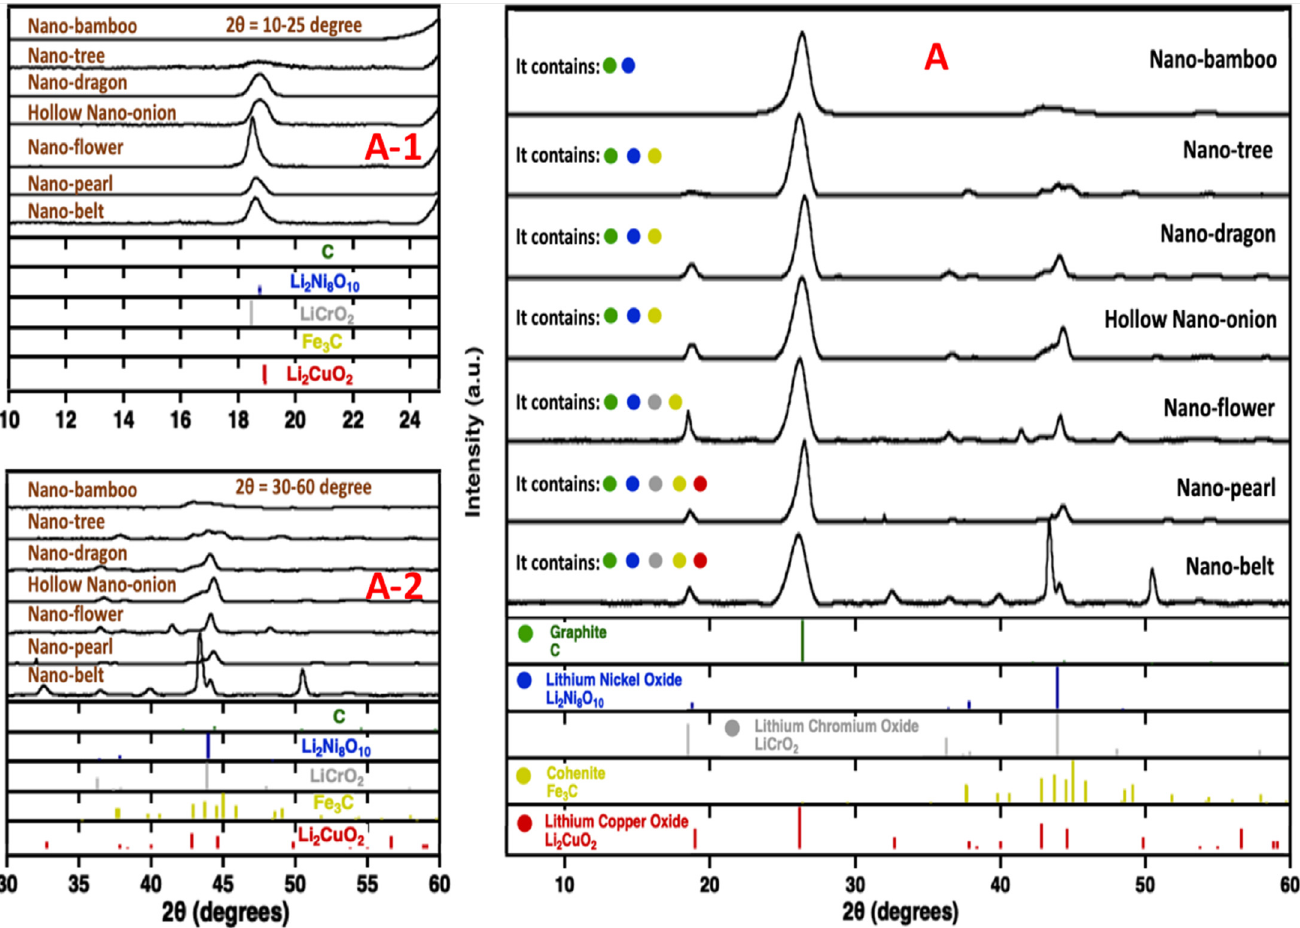
Figure 16. XRD of the synthesis product consisting of various labeled unusual nanocarbon morphologies synthesized by the electrolytic splitting of CO 2 in 770 °C Li 2 CO 3 with a variety of systematically varied electrochemical conditions. ( A , A-1 , A-2 ): XRD over various ranges of 2 θ .